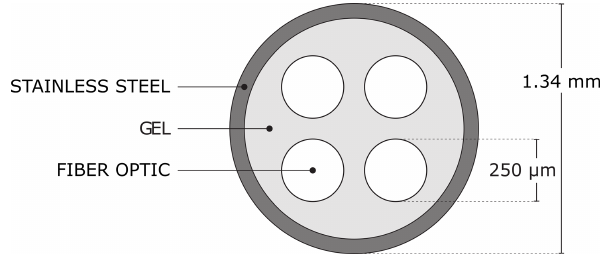
Figure A1. Cross section of the FO cable.